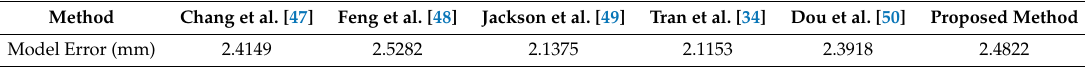
Table 4. Comparison results with other state-of-the-art deep learning-based approaches using the ESRC datasets. Model error over all mesh vertices (nearly 400,000) for all meshes in the ESRC datasets.